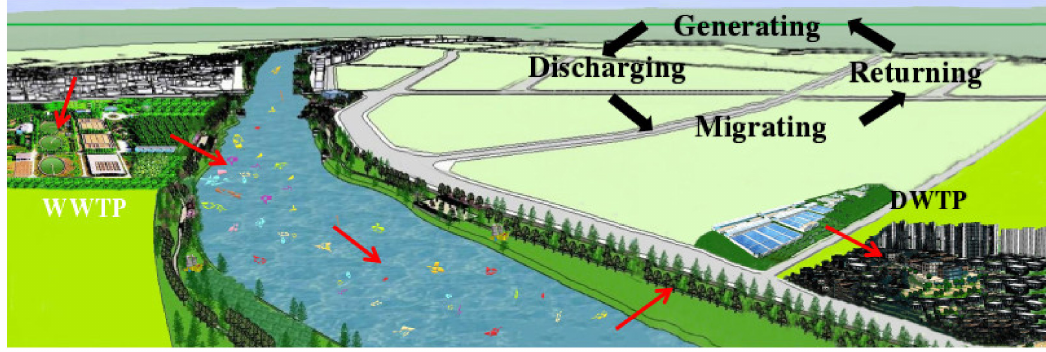
Figure 3. The migration process of microplastics in inland